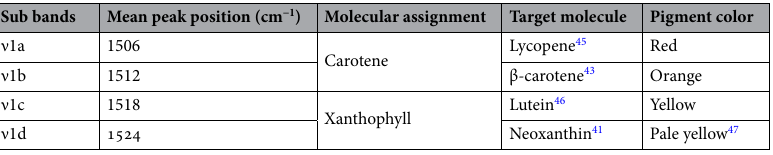
Fig. 2e. The ratios are labelled as: ν1b/ν1a, ν1b/ν1c and ν1b/ ν1d. These ratios correlate to the molecule concen- tration ratios between β-carotene and lycopene, β-carotene and lutein, and finally β-carotene and neoxanthin, respectively. Since each carotenoid molecule possess a unique color in the exocarp, the ratio also correlates to the distribution of exocarp color. The mean peak ratio of the sub bands for 3 ripeness classes are presented in Fig. 2f. During the under ripe state, β-carotene to lycopene peak ratio is observed to be the highest compared to the other ratios. This ratio increases further by 28.64% in ripe state. However, it hits the bottom with a decrease of 96.57% in over ripe state, becoming the lowest among all the other ratios. This indicates that the concentration of lycopene has increased drastically while the concentration of β-carotene has decreased during the transition from ripe to over ripe state. Likewise, the β-carotene to neoxanthin ratio has shown a similar trend. The peak ratio increases by 43.48% from under ripe to ripe state before decreasing later by 64.7% from ripe to over ripe state. Finally, the β-carotene to lutein peak ratio shows a gradually decreasing trend from under ripe to over ripe state. The last feature, FWHM of Raman bands, provides insights on physical stresses experienced by the molecule. Figure 2g shows a group box plot of extracted FWHM for the 3 ripeness classes. It was observed that the disper- sion for all sub bands in under ripe and ripe states are higher compared to over ripe state. Among all the sub bands, the FWHM of lycopene band showed the highest dispersion with standard deviation of 7.1 cm −1 during ripe state. Figure 2h presents the mean FWHM plot for all sub bands. During under ripe state, the sub band corresponding to β-carotene has the highest FWHM of all the sub bands. The FWHM of this band continues to increase slightly by 3.49% in ripe state. However, in the subsequent state, it has dropped by 20.3%, becoming the second highest FWHM after the lycopene sub band. The FWHM of the lycopene sub band shows an opposite behavior in contrast to β-carotene sub band. Initially, the FWHM of lycopene sub band dropped by 12.78% during under ripe to ripe state transition. This value subsequently increased by 48.23% from ripe to over ripe state. The last two sub bands corresponding to lutein and neoxanthin shows similar trend with lycopene sub band at a smaller scale. Statistical analysis. A total of 15 features from the extracted sub bands were discriminated using statisti- cal evaluation. The ANOVA test for all sub band peak intensities showed positive results. Further post hoc test concluded that β-carotene and lutein sub bands are statistically significant in distinguishing between all states. Therefore, they are potential candidates to be used in the classification analysis. Meanwhile, the peak intensity of neoxanthin sub band is found to be significant only for distinguishing between under ripe and ripe states. The